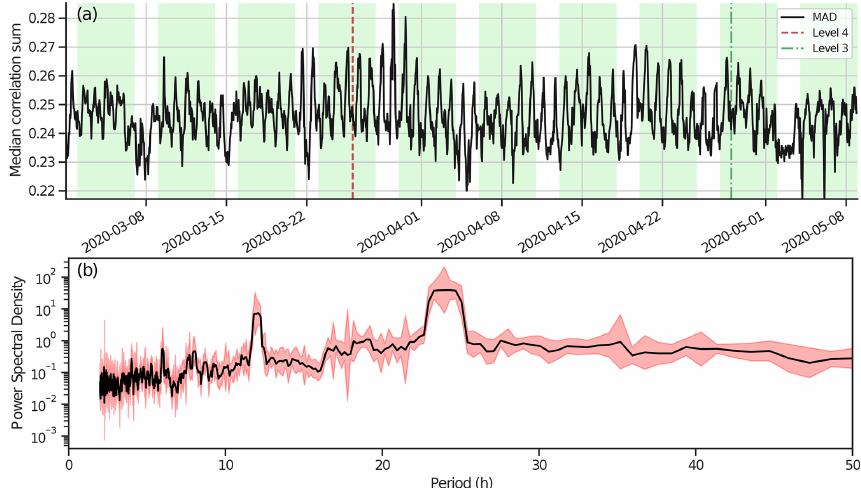
Figure B1. (a) The median cross-correlation sum for the AVSN against a template of one of the GeoNet-located earthquakes, showing no reduction in this value for the lockdown period. (b) Weighted multitaper spectrum with 5% and 95% confidence intervals of the top panel time series. Spikes at 12 and 24h confirm the noise is dominated by the difference between night- and daytime noise